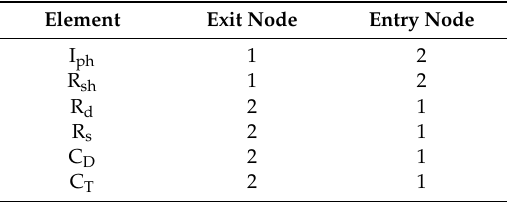
Table 2. Netlist for scheme on Figure 4 from Microcap.